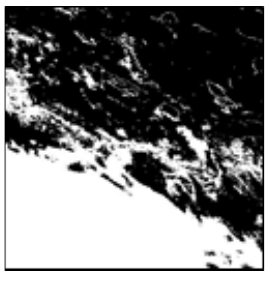
Figure4. Cloud mask based on the decision tree Because the daily data will be available, it is easy to composite.